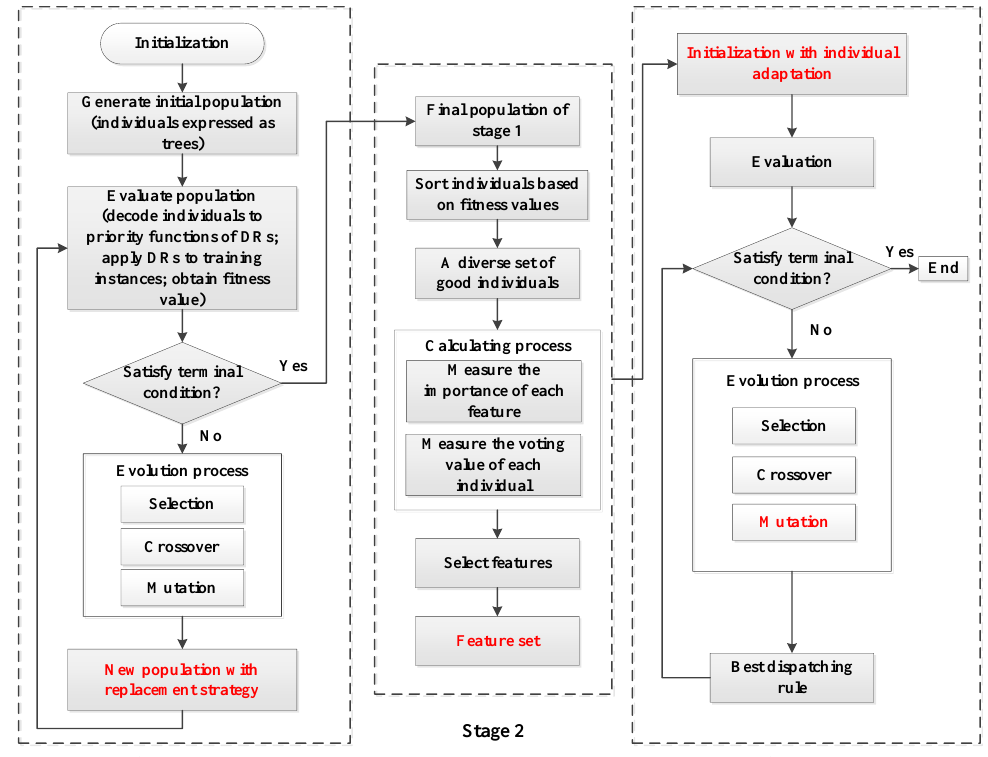
Figure 2. Flowchart of the proposed novel genetic programming with online feature selection.